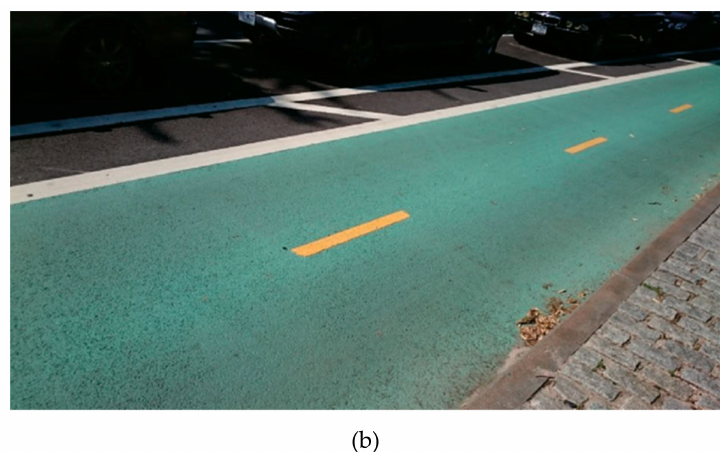
Figure 9. Examples of photocatalytic cement-based coatings that contain TiO 2 thin film: ( a ) parking lot view (Phoenix, AZ, USA) and ( b ) bike lane (Brooklyn, NY, USA). Reprinted with permission from [23]. Copyright © 2016, Higher Education Press and Springer-Verlag Berlin /